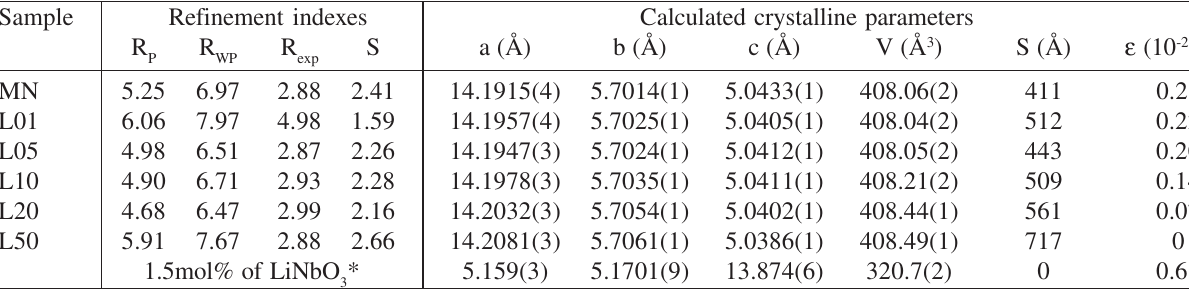
Figure 2. Scanning Electronic Micrographs for: a) MN and b) K50 Table 3. Refinement results for Li-doped MN samples.